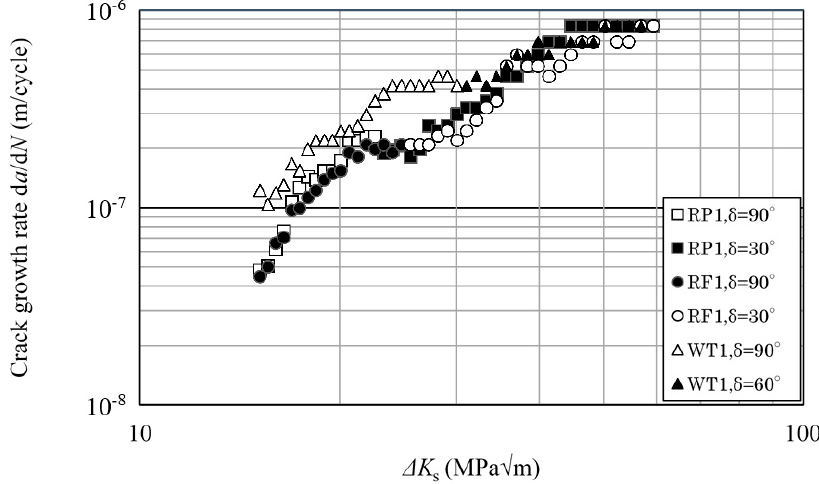
Figure 8. Coplanar crack growth rates against Δ K s for RF.